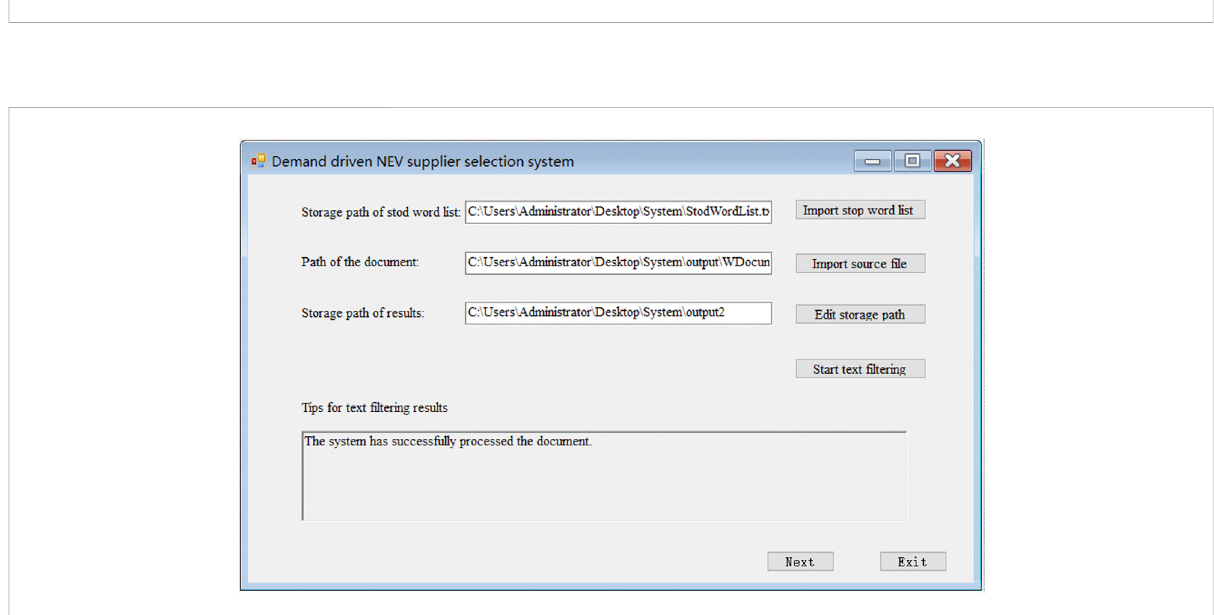
FIGURE 6 Stop word deletion